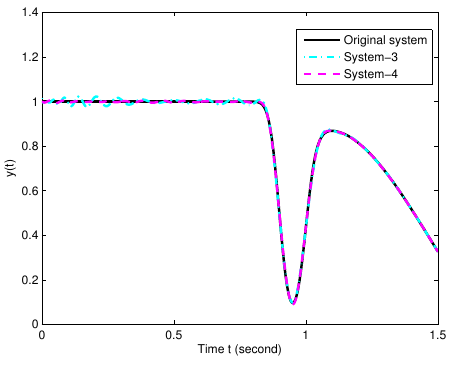
Figure 3. Transient responses in Example 2